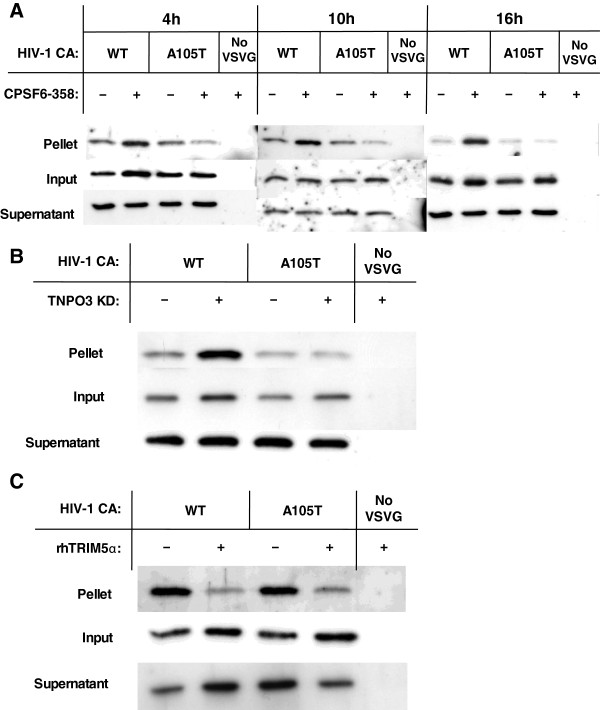
CPSF6 stabilizes the HIV-1 CA core. (A) Env- HIV-1, pseudotyped with VSV G, and bearing either WT or A105T mutant CA, was incubated with TZM-bl cells stably transduced with CPSF6-358 (+) or empty vector (−), for 4, 10 and 16 hours. As a control, virions lacking VSV G (No VSVG) were also incubated with CPSF6-358 expressing cells. The target cells were lysed and the cytoplasmic fraction (Input) was pelleted through a 50% sucrose cushion to separate the particulate (Pellet) and soluble fractions (Supernatant). The fractions were then analyzed by western blot with an antibody anti-p24. (B) WT or A105T CA mutant viruses, and no VSV G virus, were incubated with control (Ctrl) or TNPO3 KD cells for 12 hours. Separation and analysis of the three fractions was described in (A). (C) WT or A105T CA mutant viruses and Env- virus were incubated with TZM-bl cells stably transduced with rhTRIM5α expressing vector or with an empty vector for 12 hours. Separation and analysis of the three fractions was described in (A). All experiments are representative of at least 2 repetitions.